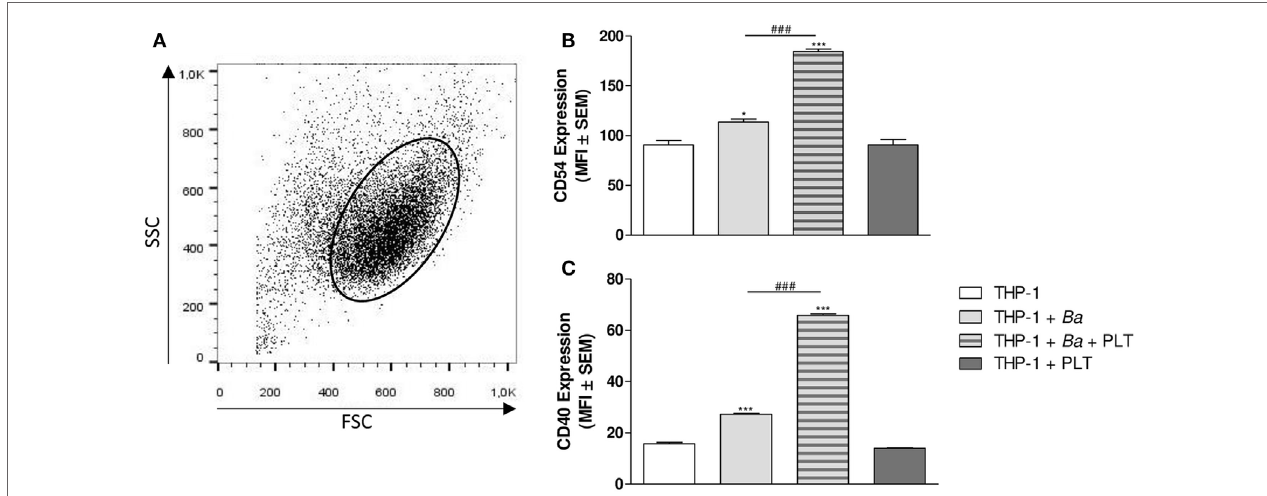
FigUre 7 | Platelets modulate adhesion and co-stimulatory molecules expression on monocytes in the context of Brucella abortus infection. THP-1 cells were infected with B. abortus in presence or absence of platelets for 4 h. (a) Monocyte population was identified in a FSC vs. SSC dot plot. The surface expression of CD54 (B) and CD40 (c) was assessed by flow cytometry within this region. Bars represent the arithmetic means ± SEM of five experiments. MFI, mean fluorescence intensity. * P < 0.05; *** P < 0.001 vs. THP-1. ### P < 0.001 vs. THP-1 + Ba . THP-1:PTL: Ba